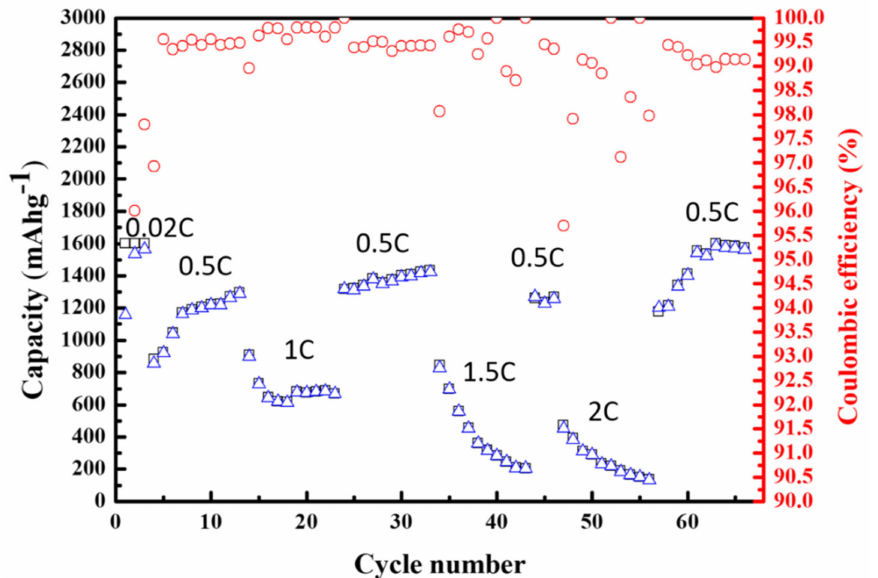
Figure 12. Cycling performance of a LIB half-cell with an anode made of silicon flakes coated with nanocarbons at 650 ◦ C. Discharging–charging rate varies from 0.02 to 2